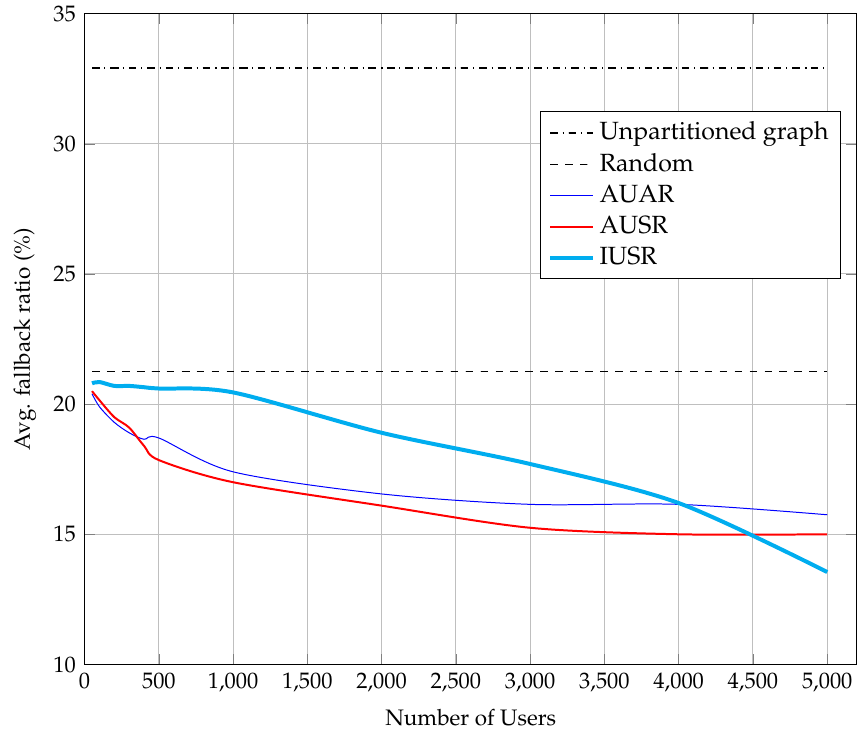
Figure 5. Average percentage of fallback predictions for different number of replicated users in each scenario.